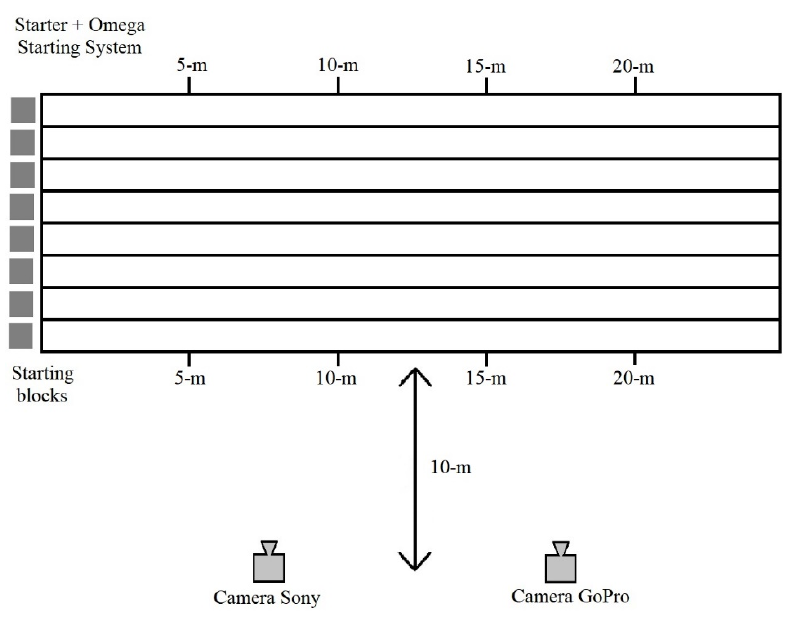
Figure 1. Arrangement of cameras in relation to the swimming pool.